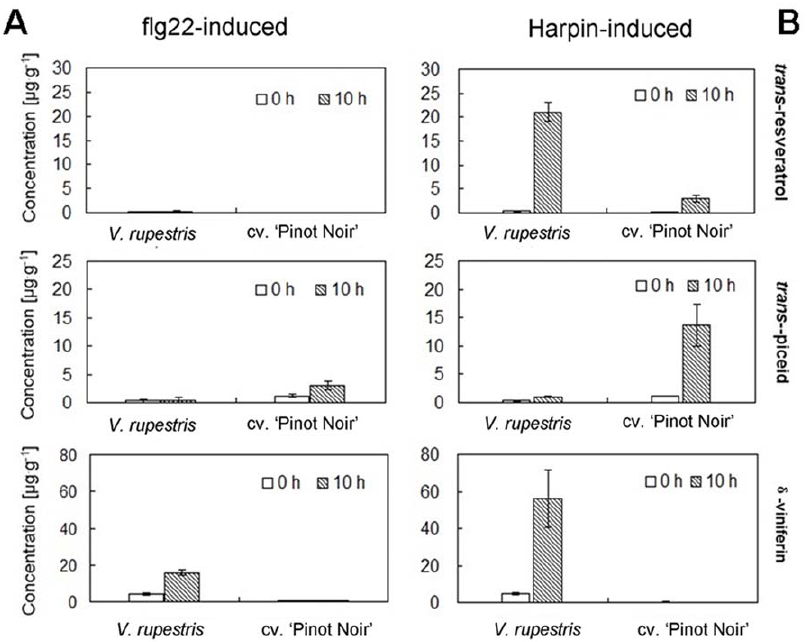
Figure 5. Stilbene accumulation in response to flg22 and Harpin. Cells of V. rupestris and V. vinifera cv. ‘Pinot Noir’ were exposed to either 1 m M flg22 or 9 m g . ml 2 1 Harpin for 0 (white bars) or 10 h (striped bars). Contents of trans -resveratrol, trans -piceid and d -viniferin were determined by HPLC and quantified relative to their corresponding calibration curves based on reference standards, respectively. Mean values and standard errors from at least three independent experimental series are shown.